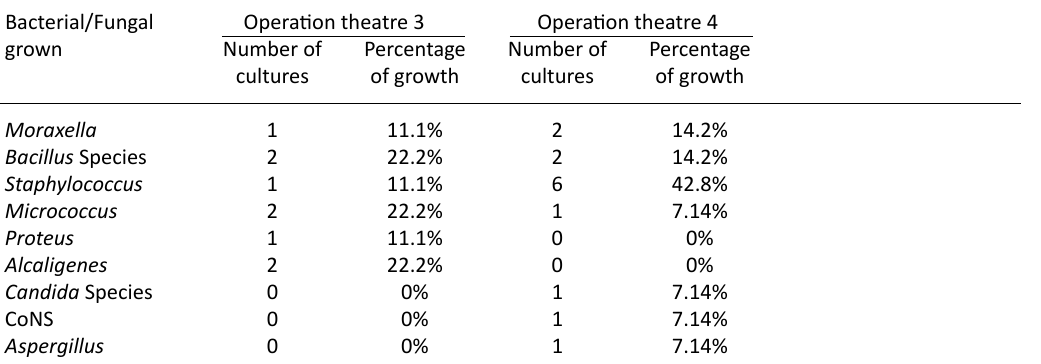
Table 2. Prevalence of microbial growth in operation theatre 3 and 4